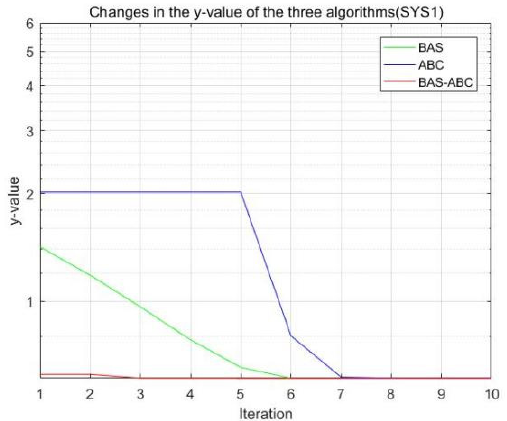
Figure 8. Changes in the 𝑦 value of the three algorithms (SYS1).